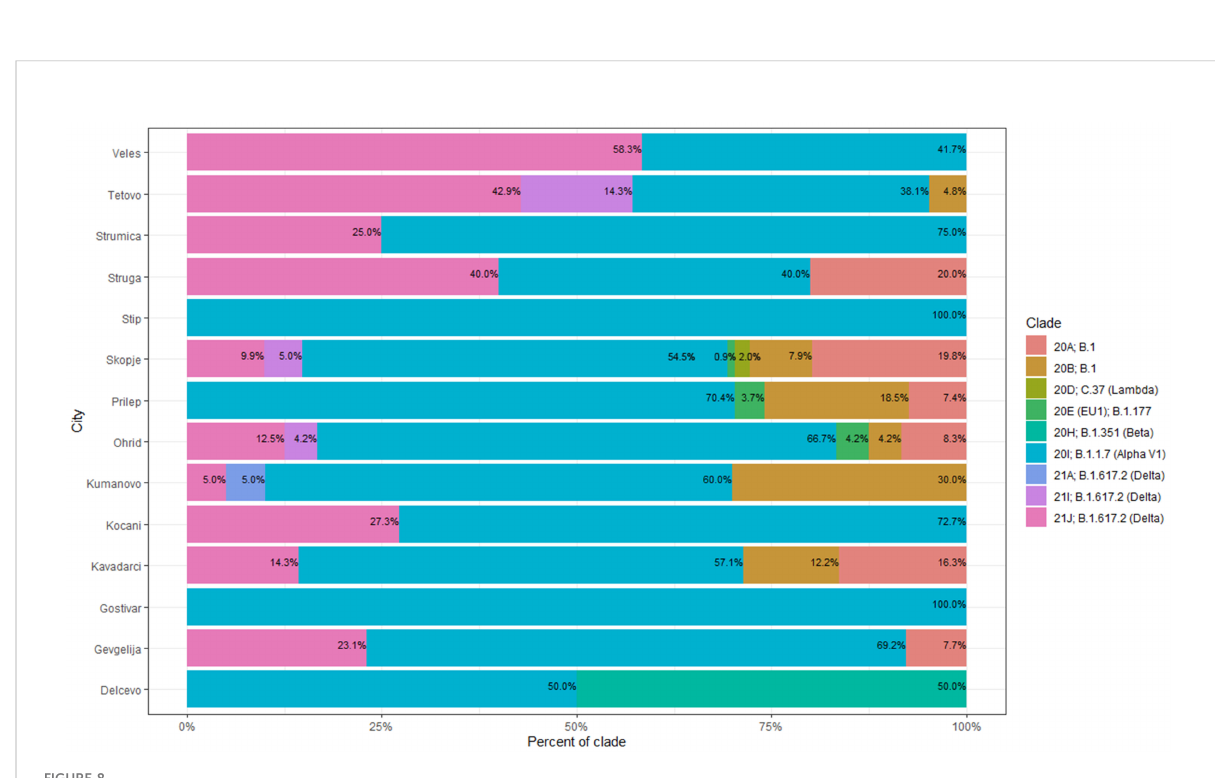
FIGURE 8 Geogrpahical distribution of SARS-CoV-2 clades in North